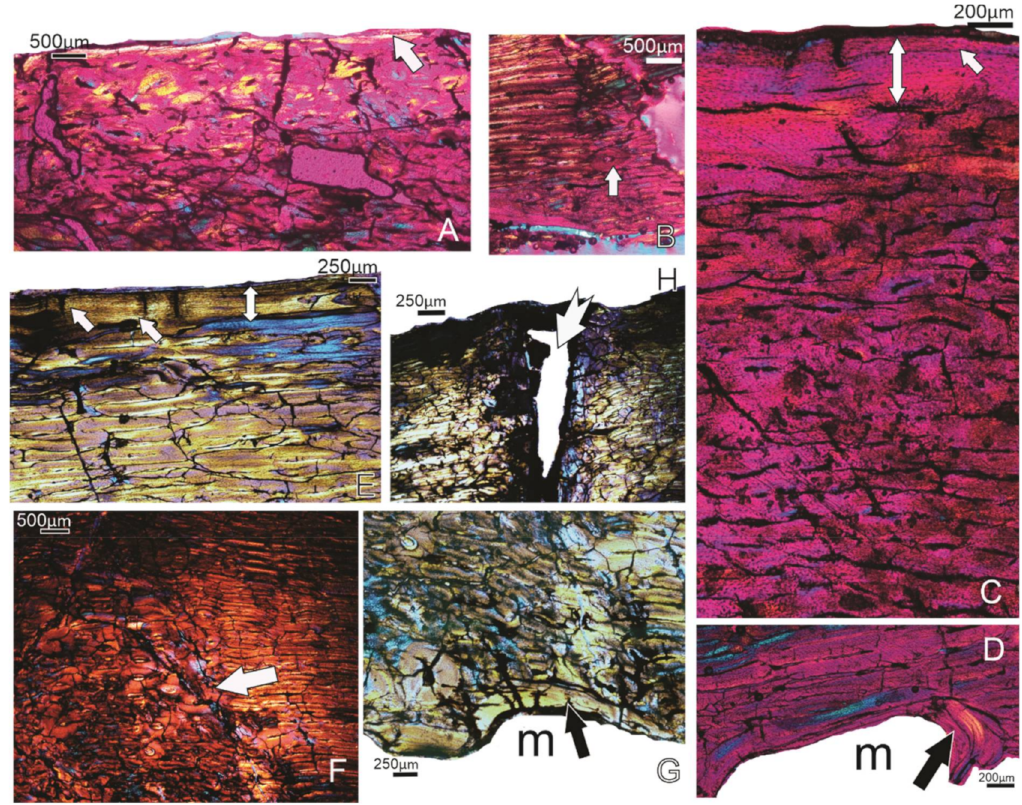
Figure 7. ( A , B ) Specimen FU2758; femur. ( A ) The white arrow points to the narrow deposit of lamellar bone tissue subperiosteally. ( B ) Some secondary osteons (arrow) are visible in the compacta. ( C , D ) Specimen FU2760; femur. ( C ) The well-vascularised compacta, and an OCL (double-headed arrow) with one LAG (arrow). ( D ) The deposition of an ICL (black arrow). ( E – H ) Specimen SAM P.53833; femur. ( E ) The OCL (double-headed arrow) and the laminar bone tissue that precedes it. ( F ) The tract of secondary osteons (arrow) that are coincident with the linea. ( G ) The uneven perimedullary margin, and the narrow ICL (arrow) in places. ( H ) The white arrow shows the entry of the nutrient foramen into the femur. Notice the changes in the orientation of the bone tissue along the margins of the canal. m, medullary